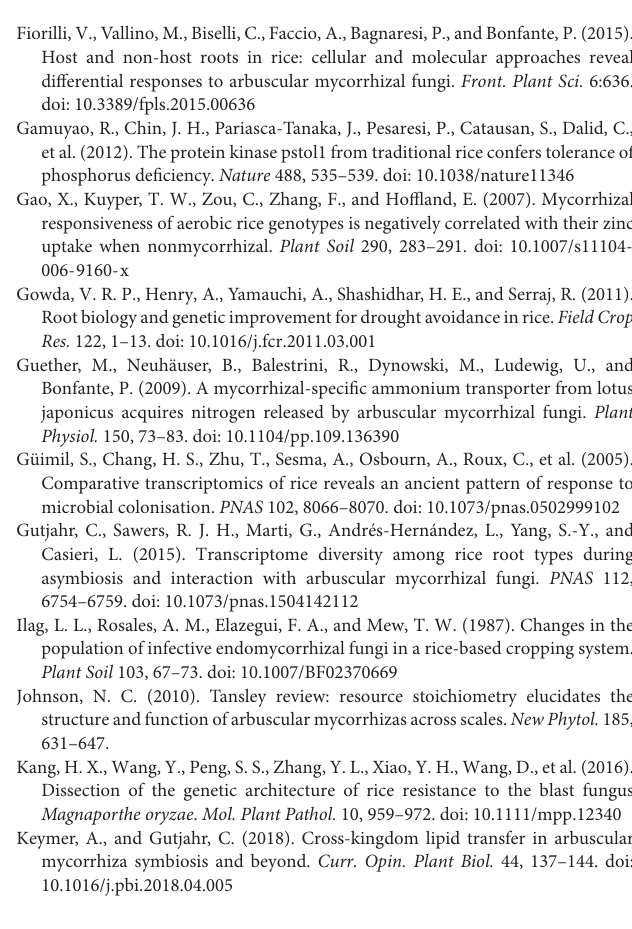
FIGURE S1 | Spatial trend in shoot dry weight (SDW), shared between all four replicate runs (showing deviations from predicted value, on the log-scale in grams). Values increase from red to white. FIGURE S2 | Raw AM colonization data showing; (A) frequency distribution of hyphal colonization in each run; (B) scatter plot of mean hyphal colonization vs. mean arbuscle colonization and; (C) hyphal colonization vs. mean vesicle colonization. FIGURE S3 | Spatial trends in hyphal colonization in each of the four replicate runs (deviation from predicted value). Units are % colonization. FIGURE S4 | Boxplots of hyphal colonization in Rice Diversity Panel 1 according to country of origin (with n in brackets). Letters above bars represent results of Tukey’s test of difference between groups. FIGURE S5 | Manhattan and QQ plots for hyphal colonization for all cultivars, aus (AUS), indica (IND), tropical japonica (TRJ), and temperate japonica (TEJ) cultivars. Red dotted lines indicate putative QTLs from the all analysis, green in subgroups. TABLE S1 | List of rice accession and phenotype data. TABLE S2 | List of genes observed in each of the putative QTLs with information on available transcriptomics data for response to AM treatment [using data from Fiorilli et al. (2015) or Gutjahr et al.